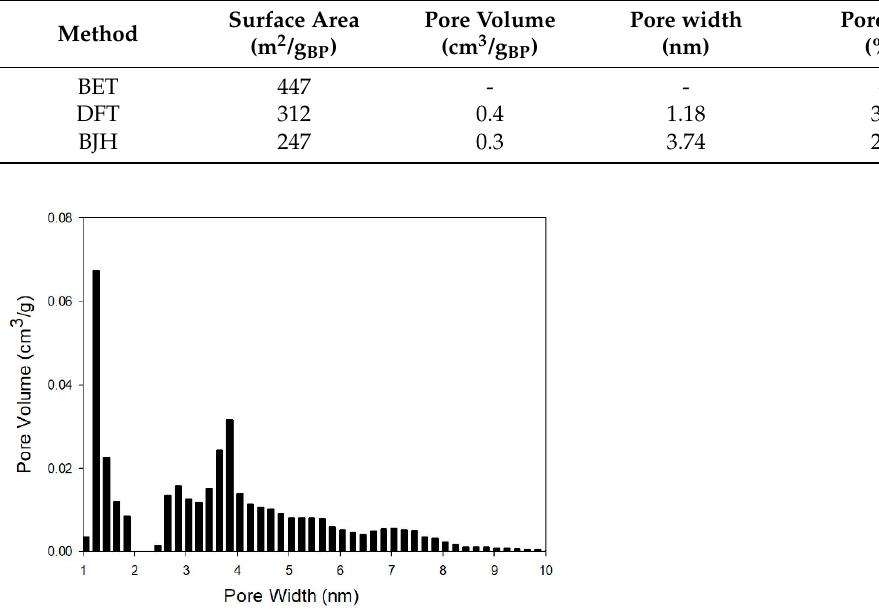
Table 1. Data obtained from physisorption results (pore width is the pore with the highest mode).